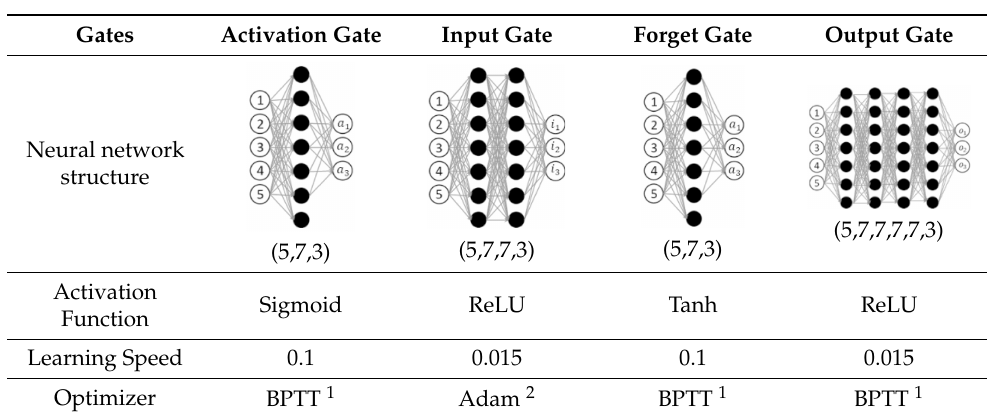
Table 4. The gate-network for gnLSTM and learning